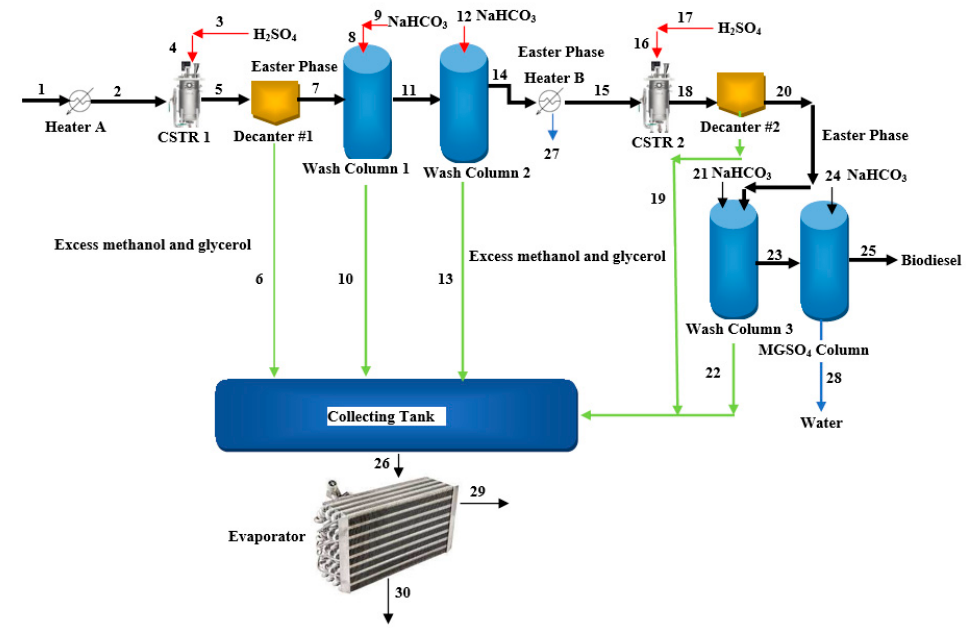
Figure 10. Process flow diagram for the synthesis of biodiesel from Jojoba seed oil.